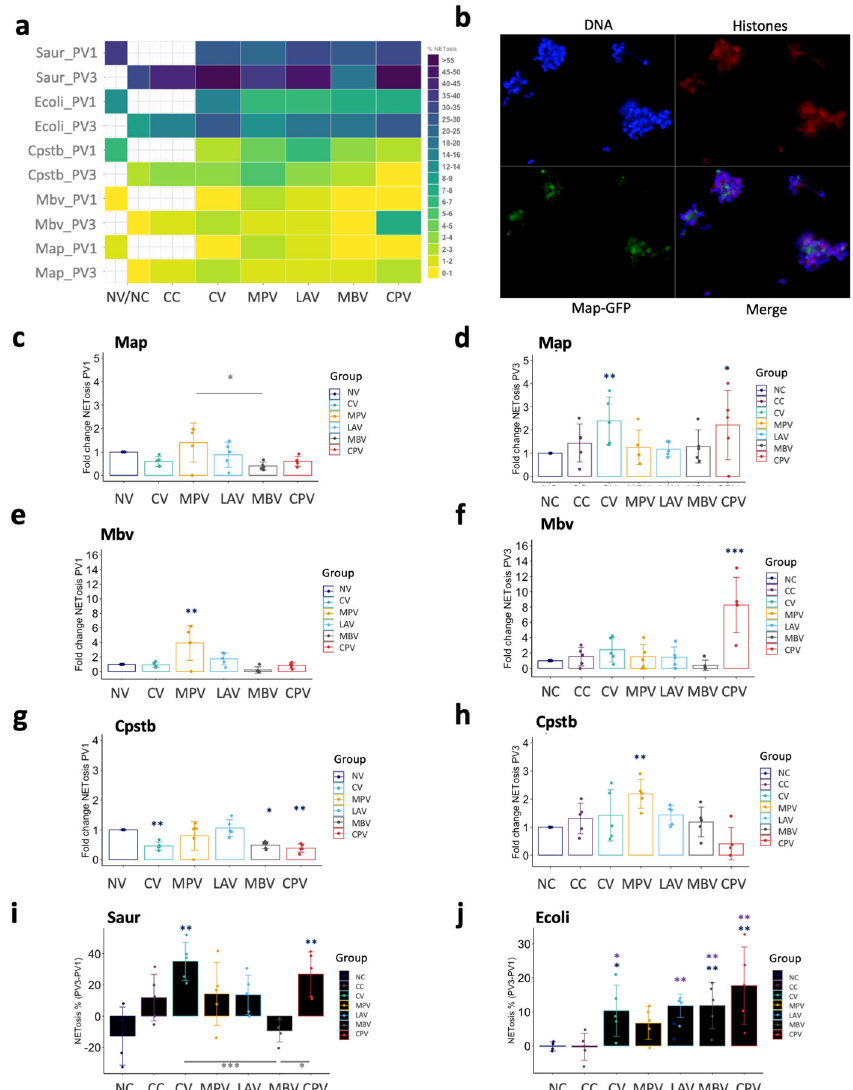
Fig. 3 Neutrophil extracellular trap (NET) release levels. NET release against Mycobacterium avium subsp. paratuberculosis (Map), Mycobacterium bovis (Mbv), Escherichia coli (Ecoli), Staphylococcus aureus (Saur), and Corynebacterium pseudotuberculosis (Cpstb) of animals Fold changes referred to non-vaccinated (NV) animals against c Map, e Mbv and g Cpstb (at time-point PV1 (1 month after fi rst dose vaccination) and against d Map, f Mbv, and h Cpstb referred to non-challenged (NC) animals at time-point PV3 (2 months after challenge). i